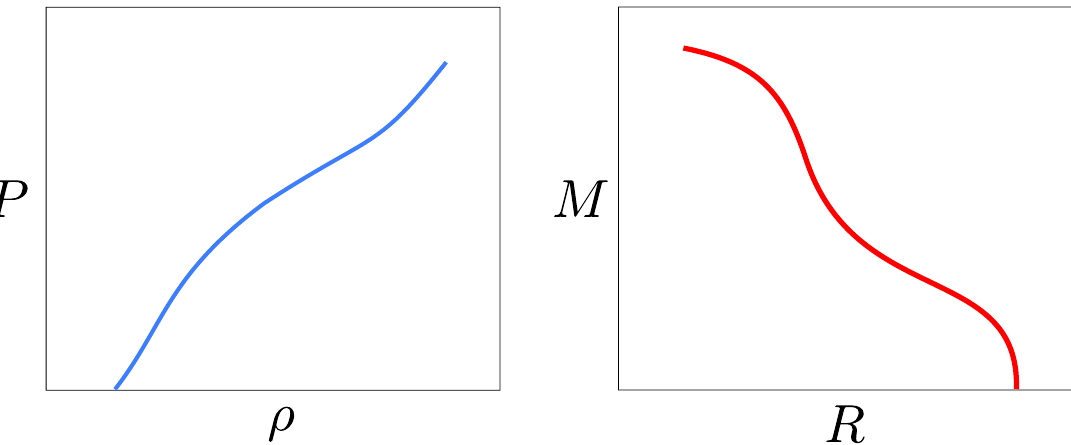
Figure 2. Schematic representation of bijective functions: measurable M ( R ) relation ( right ), from which currently unknown P ( ρ ) relation ( left ), so-called equation of state, can be